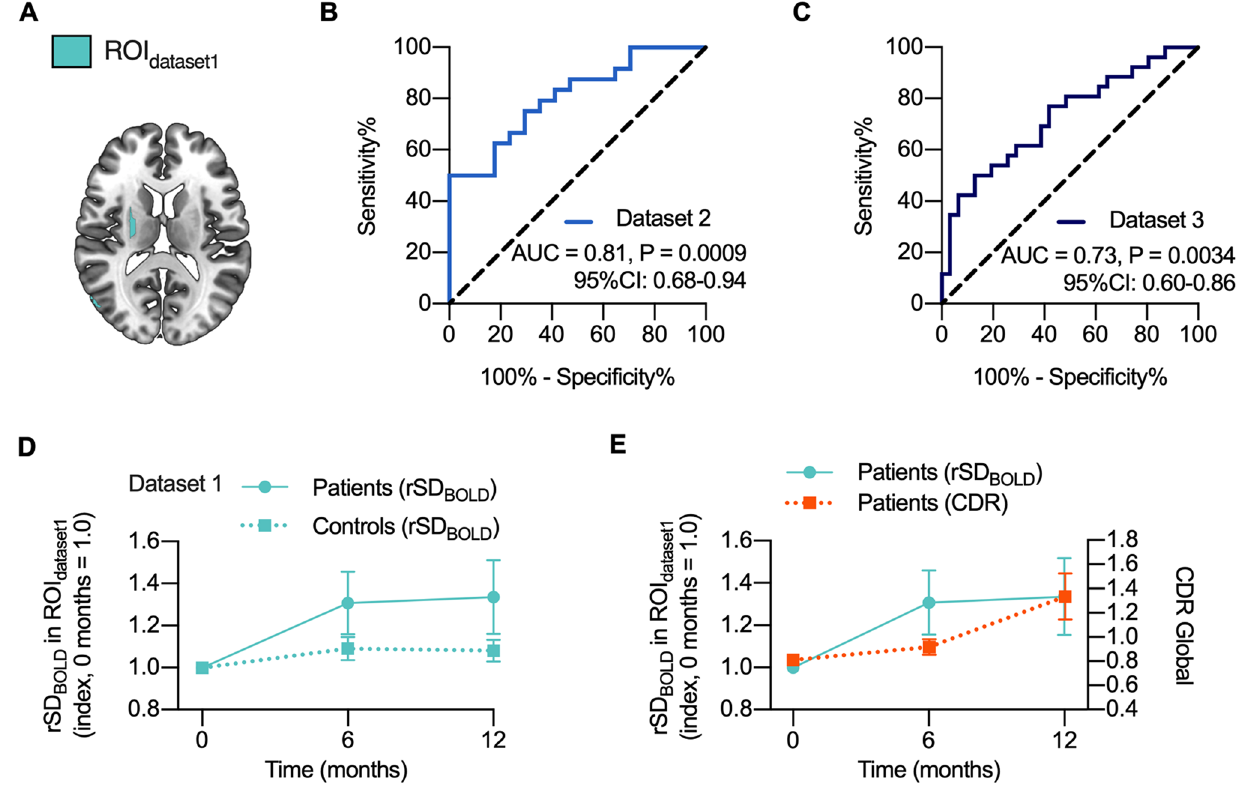
Figure 3. Accuracy and repeatability. ( A ) Region-of-interest (ROI dataset1 ) was defined by significant clusters in dataset 1 (c.f. Figure 2A). Receiver operating characteristic (ROC) curves and area-under-curve (AUC) for differential diagnosis was based on mean rSD BOLD values in datasets 2 ( B ) and 3 ( C ) within this ROI dataset1 . Confidence intervals and statistical significance are also shown. ( D ) Within-individual changes in the average rSD BOLD in ROI dataset1 over time after baseline imaging (0 months) in AD patients and controls in dataset 1. There was statistical difference between the two groups at both 6 and 12 months. Data represents the mean ± standard error of the mean. Mixed-effect analysis significance between groups p < 0.035 and between timepoints p < 0.0054 corrected for multiple comparison. Predicted mean increase was in AD 21% and in controls 5%. ( E ) presents indexed rSD BOLD change and Clinical Dementia Rating (CDR) global values in follow up in